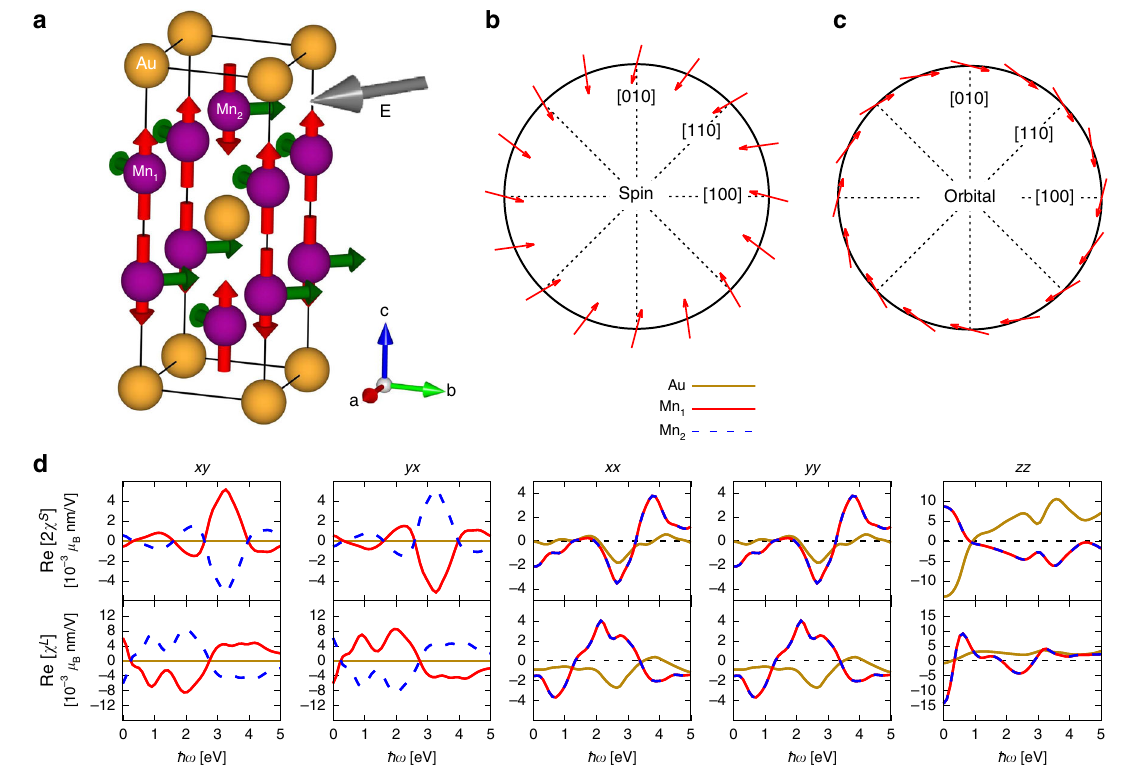
Fig. 3 Rashba-Edelstein effect in Mn 2 Au with magnetic moments along the c -axis. a The unit cell of Mn 2 Au, with red arrows on the Mn atoms depicting the initial magnetic moments. Applying an electric fi eld E along the (100) direction (gray arrow) induces a nonequilibrium magnetization tilted in between the (010) and (100) direction (green arrows). b Symmetry of the induced spin magnetization as a function of the static electric- fi eld direction for Mn 1 . c Symmetry of the induced orbital magnetization as a function of the static electric- fi eld direction for Mn 1 . d Real parts of the nonzero components ij ( i ; j ¼ x , y , or z ) of the spin and orbital Rashba-Edelstein susceptibilities, Re ½ 2 χ S (cid:5) and Re ½ χ L (cid:5) , as function of electric- fi eld frequency, _ ω